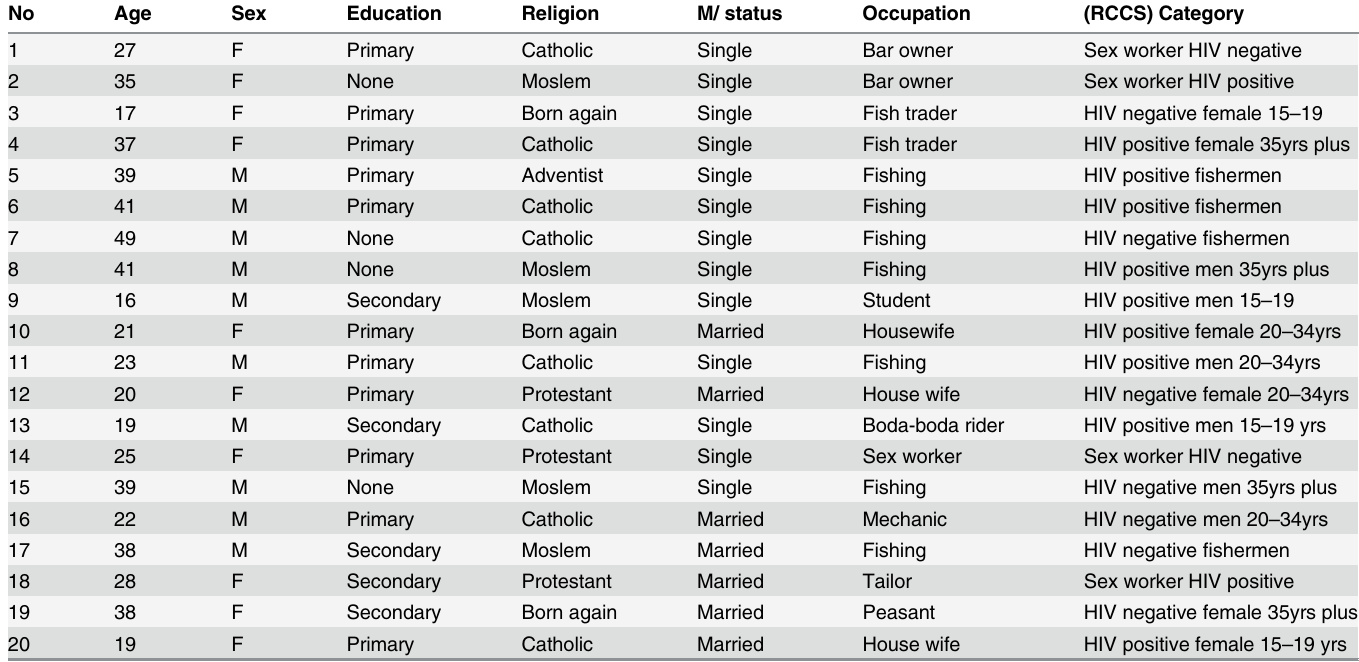
Table 1. General characteristics of in depth interviewees (IDIs) (n = 20). F Female. M